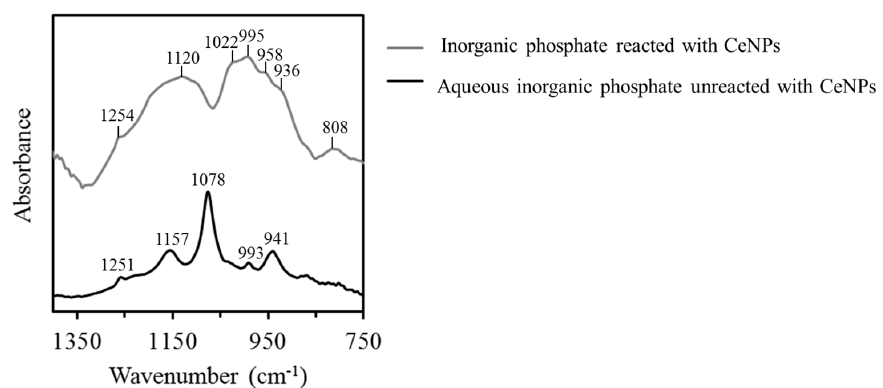
Figure 6. ATR-FTIR spectra of inorganic orthophosphate in aqueous solution and inorganic orthophosphate adsorbed onto CeNPs at pH 6.0.